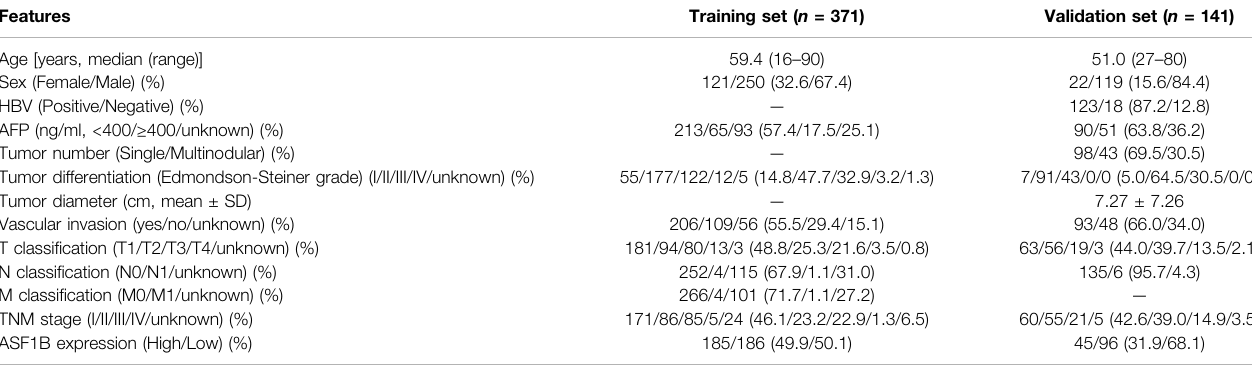
TABLE 1 | Demographics and clinicopathological characteristics of the HCC patients in TCGA database and our Center.